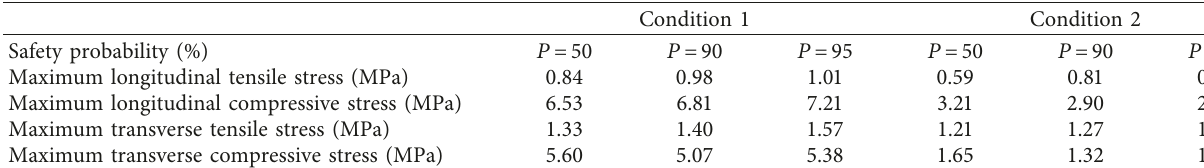
Table 8: Maximum stress of the bed plate.